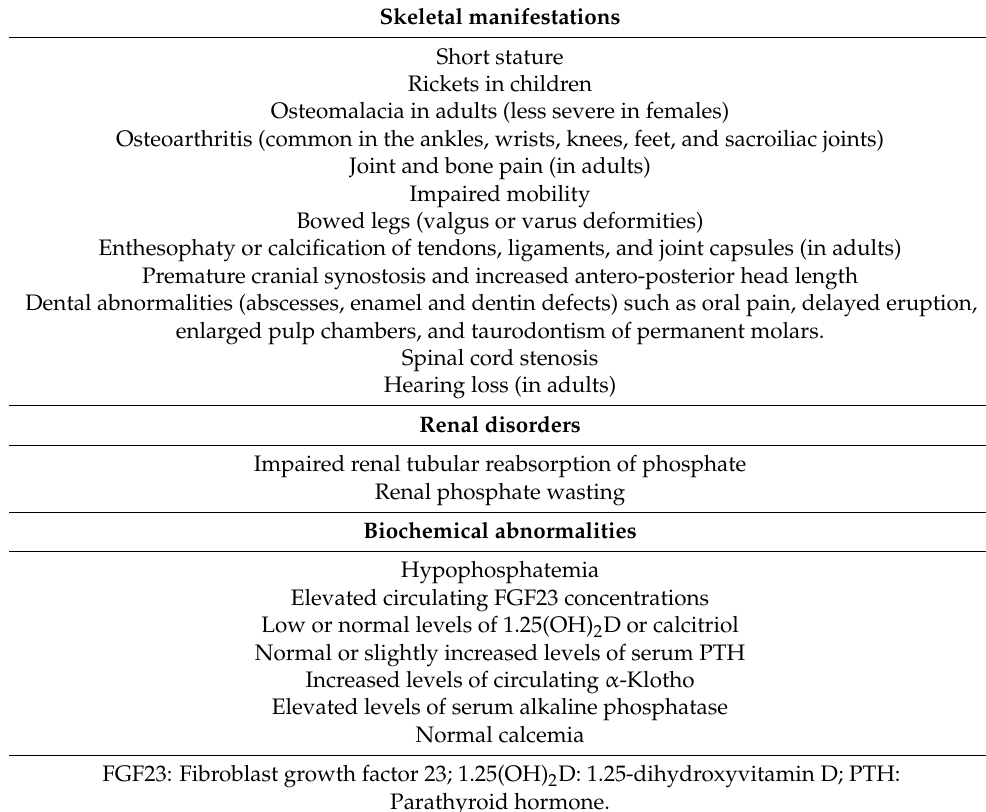
Table 1. Clinical and biochemical characteristics of X-linked